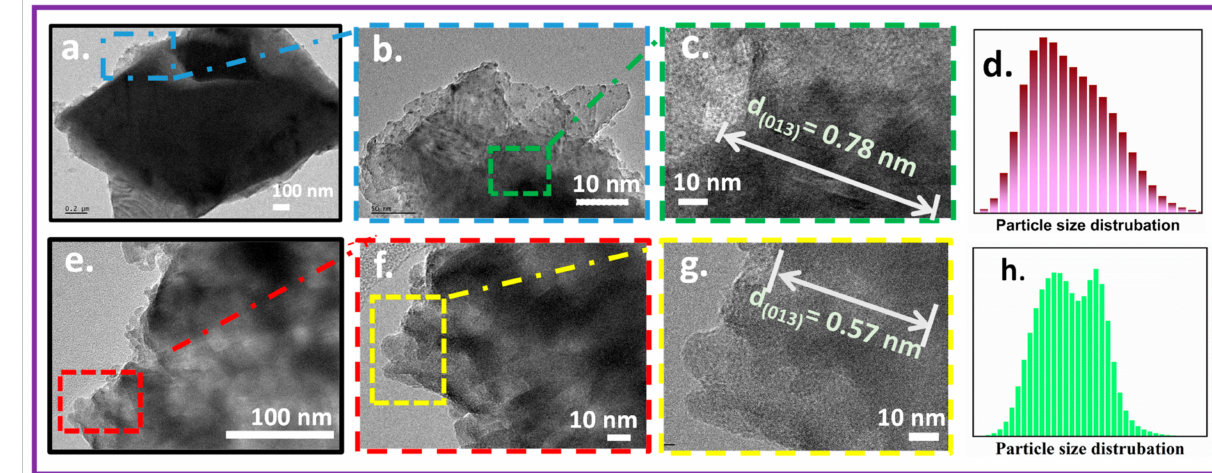
Figure 13. TEM micrographs of the unpromoted catalyst (Blank-VPO) ( a – c ) and their histogram ( d ). TEM micrographs of the Zr-DES-VPO catalyst ( e – g ) and their histogram ( h ). The spacing of the catalyst was measured along d (013) , which provided information about the crystallite size of the